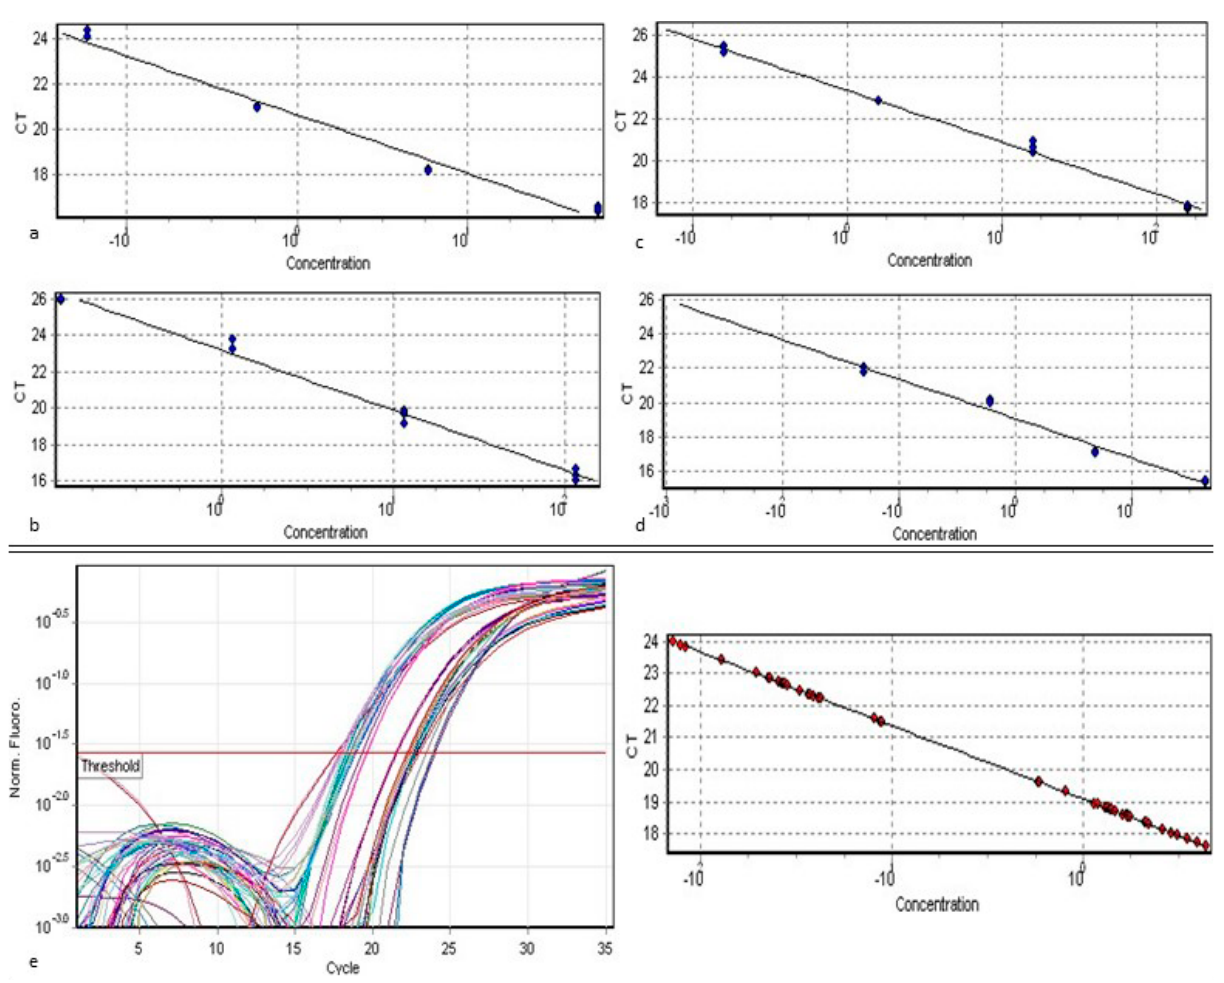
Figure 2. Standard curves resulting from Real-Time q PCR quantifications: a), b) and c) show, respectively, Act standard curves for wheat genotypes ‘Palesio’, ‘Claudio’ and ‘Marco Aurelio’ pure DNAs. d) shows the Tri6 standard curve for F. graminearum pure DNA. e) shows amplification curves of the Tri6 gene (left) and interpolations with the standard curve